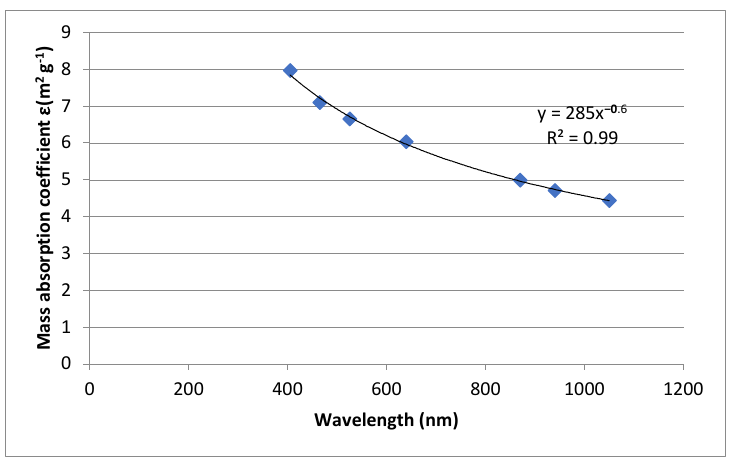
Figure 2. The mass absorption coefficient ( ε ) versus wavelength ( λ ) obtained for sampling from the Krakow site.